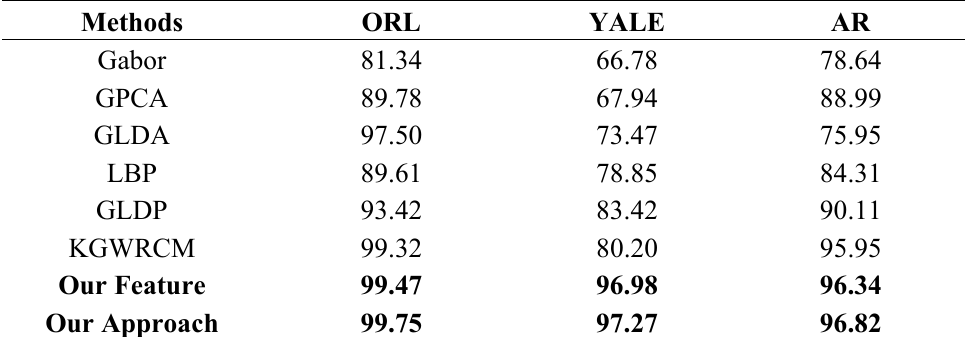
Table 1. The Recognition Rate (%) based on ORL, YALE, and AR Database.